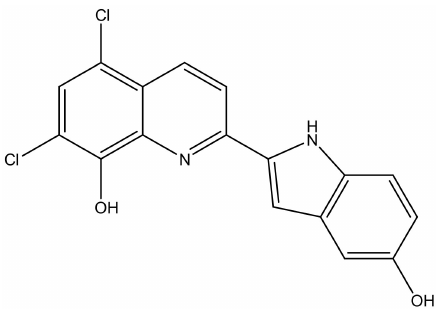
Figure 4. Compound WI-1758 [33].